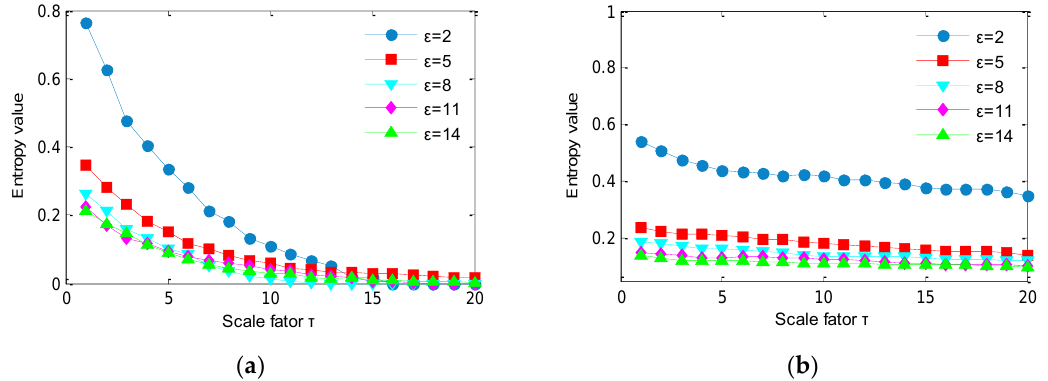
Figure 6. IMSDE of two noises for different data length: ( a ) IMSDE of white noise and ( b ) IMSDE of 1/f noise. Figure 7. IMSDE of two noises for different symbols: ( a ) IMSDE of white noise and ( b ) IMSDE of 1/f noise.